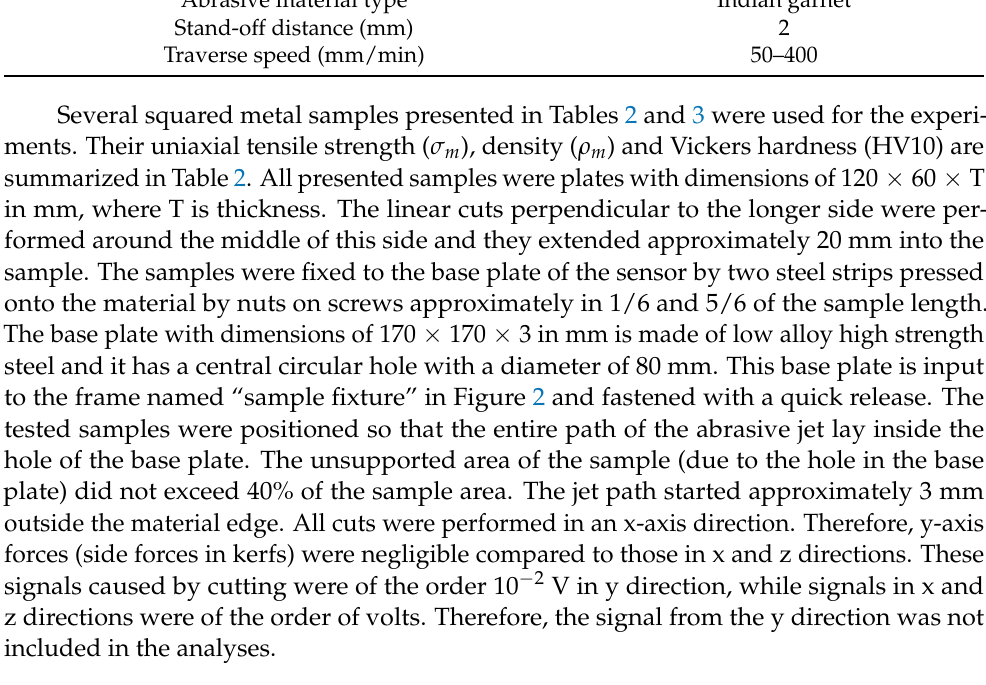
Table 2. Materials used in experiments (10 mm thick). σ m : uniaxial tensile strength; ρ m : density; HV10: Vickers hardness.